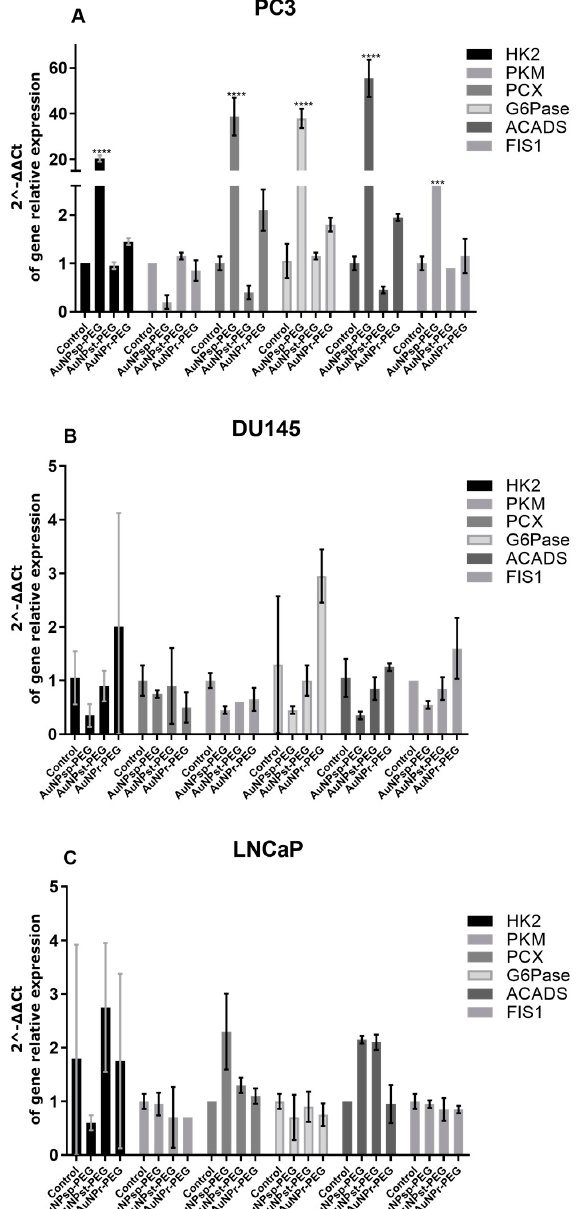
Figure 7. RT-qPCR analysis of genes transcripts involved in different metabolic pathways—hexokinase-2 (HK2) and pyruvate kinase (PKM) on glycolysis, glucose-6-phosphatase (G6Pase) and pyruvate carboxylase (PCX) on gluconeogenesis, acyl-CoA dehydrogenase